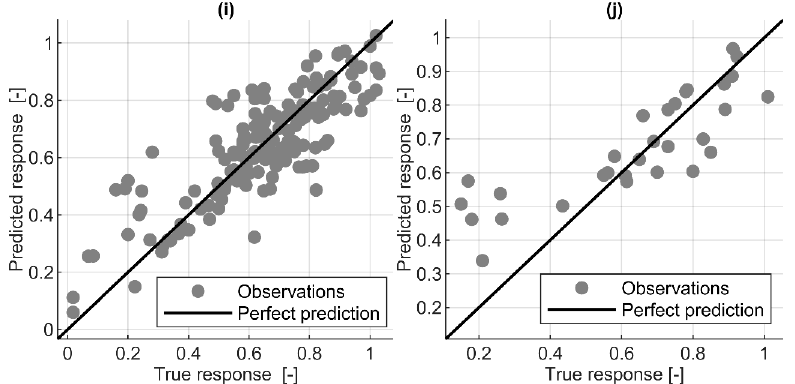
Figure 4. Comparison of the prediction accuracy for the best model within different ML approaches and LR: training and validation: ( a ) RT, ( c ) SVM, ( e ) ET, ( g ) ANN, ( i ) LR; testing: ( b ) RT, ( d ) SVM, ( f ) ET, ( h ) ANN, ( j ) LR.